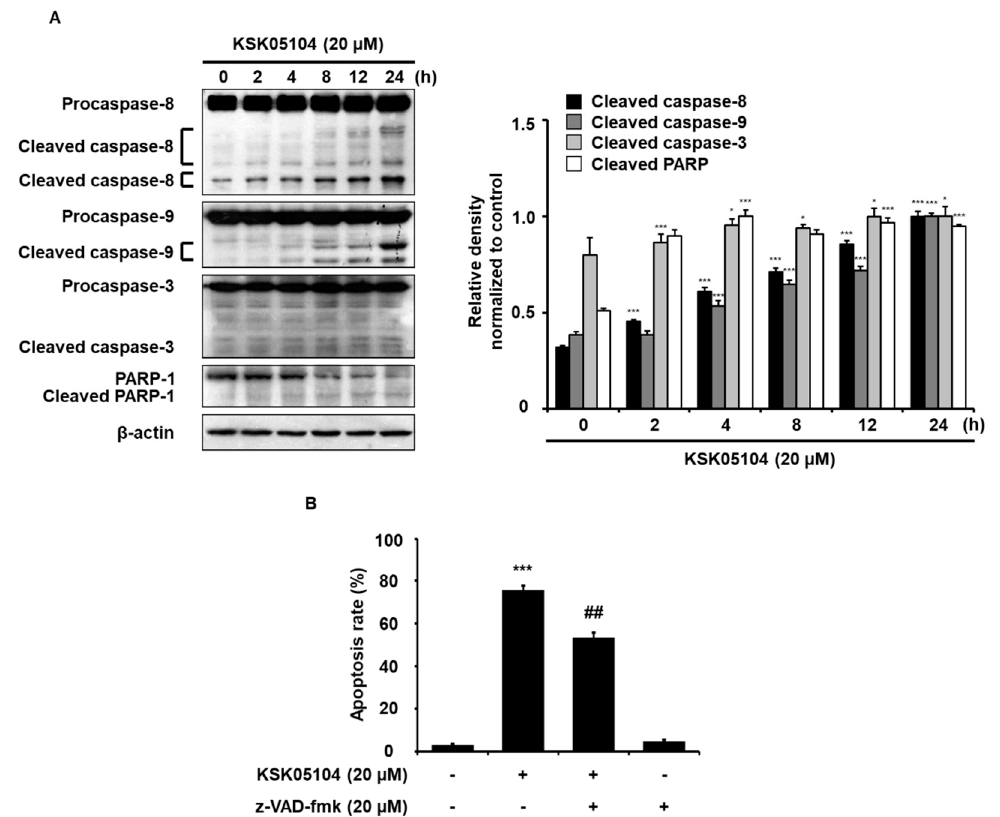
Figure 3. Effect of KSK05104 on the activation of caspases in HT-29 cells. ( A ) HT-29 cells were treated with 20 µ M KSK05104 for the indicated times to examine the expression of caspase-8, -9, -3 and PARP-1 via Western blot analysis. Ratio of relative density was determined by a densitometric analysis program (Bio-rad Quantity One ® Software) normalized to internal control; ( B ) Cells were pretreated with 20 µ M z-VAD-fmk for 1 h and then treated with or without 20 µ M KSK05104 for 24 h. Cells were co-stained with PI and FITC-conjugated Annexin V, and the translocation of PS was detected by flow cytometry after treatment with KSK05104. Data presented are the means ± S.D. of results from three independent experiments. * p < 0.05, *** p < 0.001 vs. non-treated control group, ## p < 0.01 vs. KSK05104-treated control group.